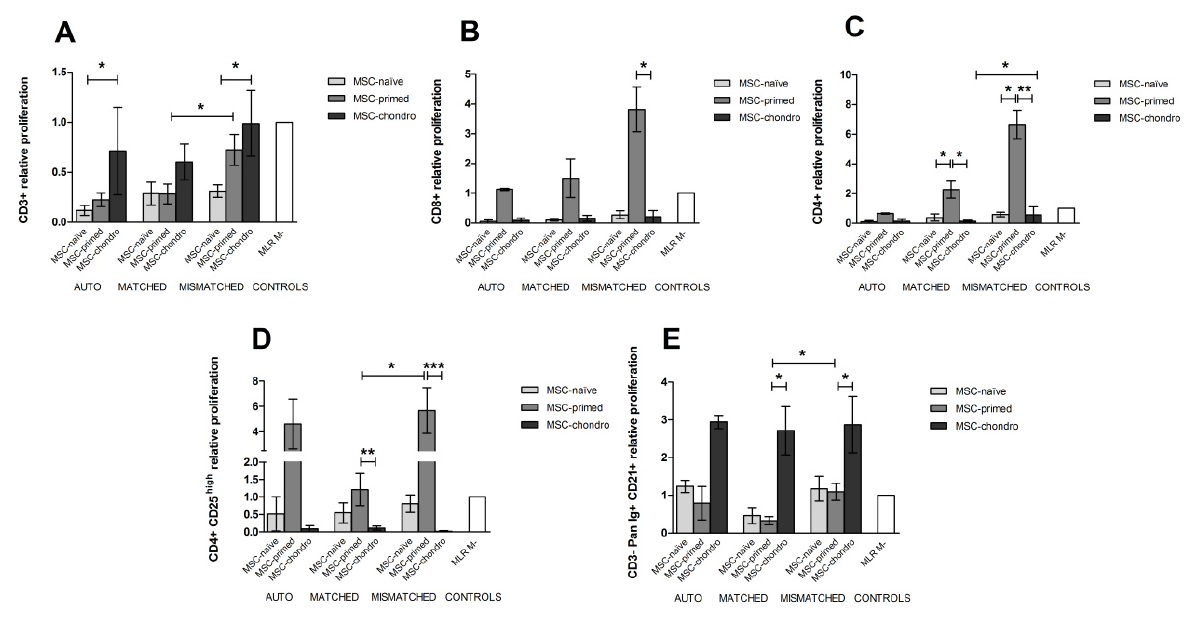
Figure 6. Mean ± SEM of the relative proliferation of different lymphocyte subsets in the immunogenicity assays (one-way modified mixed lymphocyte reaction): ( A ) CD3+ T lymphocytes, ( B ) CD8+ cytotoxic T cells, ( C ) CD4+ helper T cells, ( D ) CD4+ CD25 high regulatory T cells, ( E ) CD3 − Pan-Ig+ CD21+ B cells. Non-activated PBLs were exposed in vitro to MSC-naïve (light grey bar), MSC-primed (medium grey bar) and MSC-chondro (dark grey bar). Co-cultures of MSCs and PBLs were autologous ( n = 3) or allogeneic, matched ( n = 8) or mismatched ( n = 7) for the MHC. Proliferation of each PBL donor is normalised over the proliferation observed in the negative control (MLR M − , matched MLR) consisting of responder PBLs from the same donor exposed to MHC-matched stimulator PBLs (value 1), to account for inter-individual variability. Significant differences over the negative control (MLR M − , white bar) were not observed. Significant differences between experimental conditions are represented by a squared line with an asterisk (* = p < 0.05; ** = p < 0.01; *** = p < 0.001).